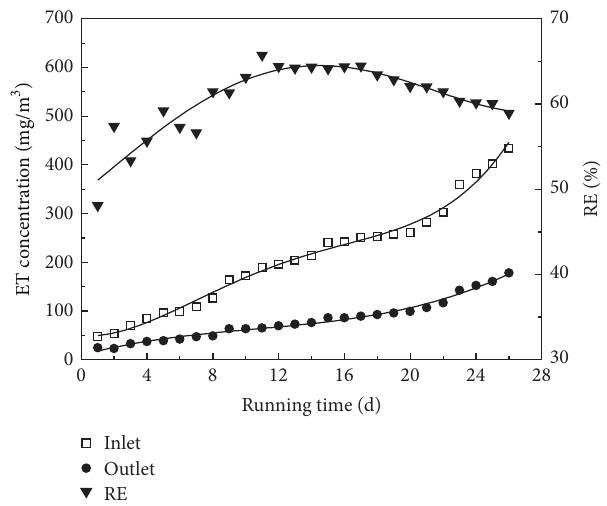
Figure 2: The ethanethiol inlet and outlet concentration and removal efficiency in start-up